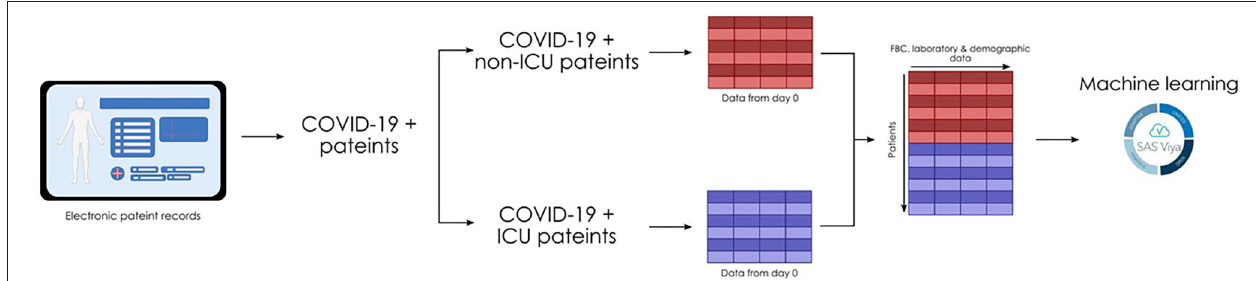
FIGURE 1 | A schematic of patient data collection for decision modeling. Data of COVID-19-positive patients were extracted retrospectively from a central database. Data from the day of positive swab was extracted from severe COVID-19 patients (requiring critical care during their hospital stay) and non-severe COVID-19 patients (not requiring critical care during their hospital stay). Data were amalgamated, pre-processed, and subjected to machine learning.